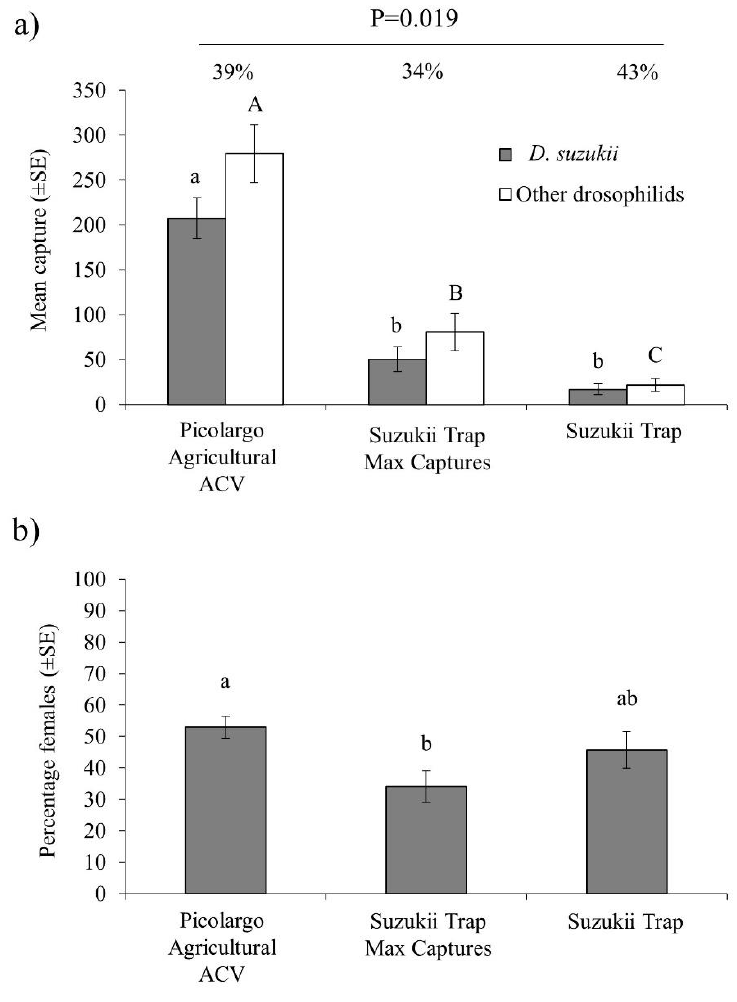
Figure 3. Results of second field trial ( a ) mean number of D. suzukii flies and other drosophilids captured per trap per week over the three-week trial and ( b ) mean percentage of females captured in traps containing agricultural-grade ACV, Suzukii Trap and Suzukii Trap Max Captures. Columns headed by di ff erent letters di ff er significantly for captures of both sexes of D. suzukii (lower case letters) or other drosophilid species (upper case letters) (GLM, p < 0.05). Vertical bars indicate SE. Species specificity percentage values are shown above columns in ( a ) (GLM, p =